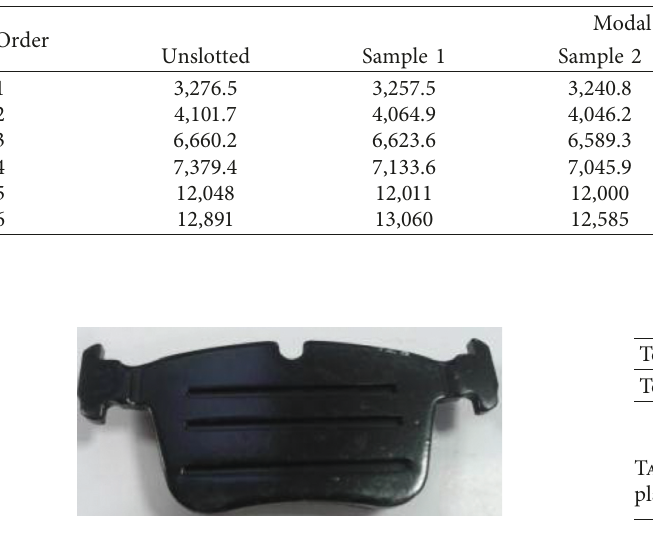
Figure 11: Test piece of Sample 3.